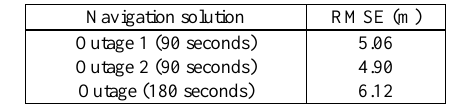
Table 3. Position RMSE for 3D RISS navigation